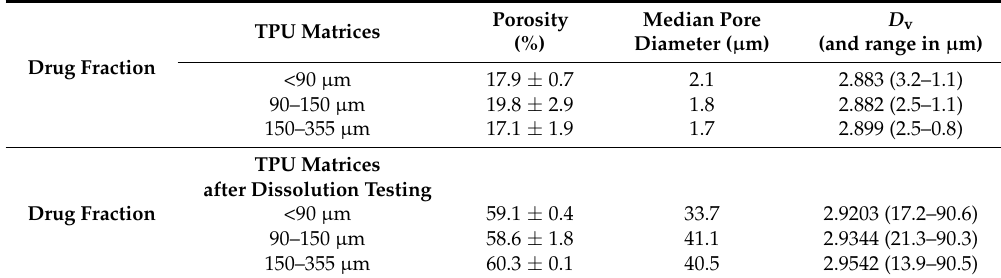
Table 2. Porosity and fractal dimension D v of TPU matrices obtained by ultrasound assisted compression (USAC), containing three different fractions of theophylline.